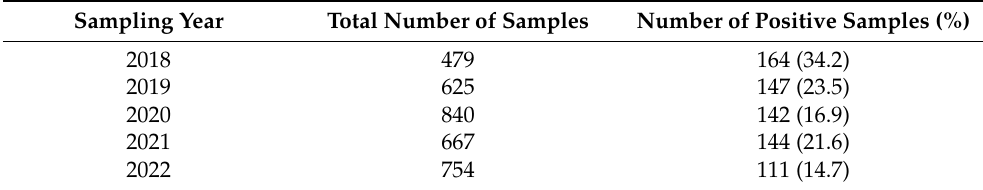
Figure 2 . Number of collected samples, number of positive samples, and positivity percentages by sampling year. Table 1. Summary of the total number of samples collected during the 5-year study period (2018–2022) with the number of positive samples and related percentages.